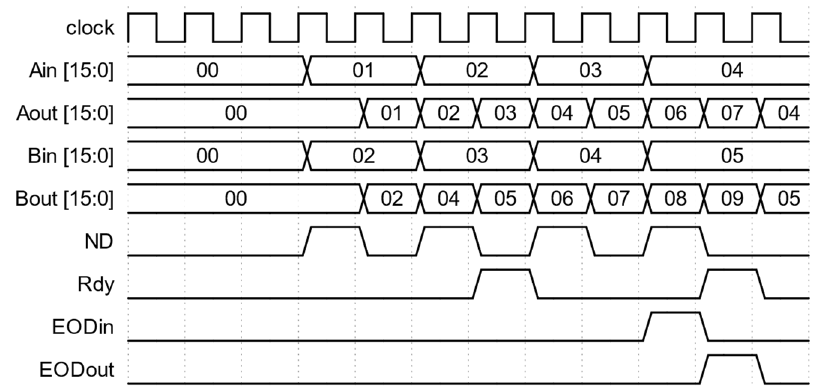
Figure 6. Waveforms of inputs and outputs for the combiner module. The Aout and Bout combine two consecutive values from Ain and Bin. The Rdy signal is active high every two valid ND pulses.